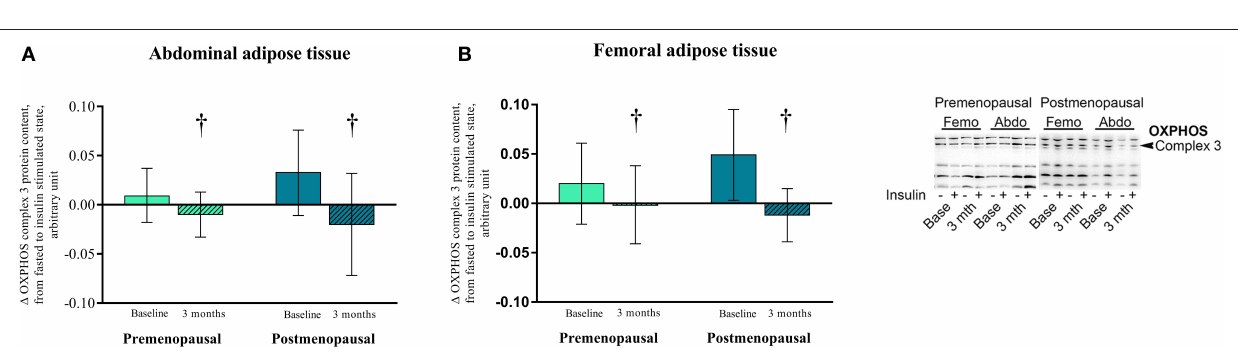
FIGURE 8 | The effect of 120min of hyper insulin stimulation on OXPHOS complex 3 (delta value, arbitrary units) in abdominal and femoral adipose tissue in pre- and post-menopausal women before and after 3 months of high-intensity training. Difference from baseline to 3 months † p ≤ 0.05. Data are presented as mean (95% confidence